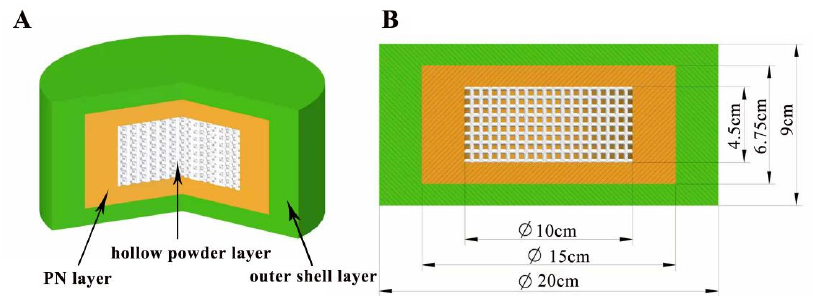
Figure 1. Design diagram of the three-layer nested structure model. ( A ) Three-dimensional section view (from inside to outside: hollow powder layer; PN layer; outer shell layer); ( B ) Dimension drawing of the side view model.